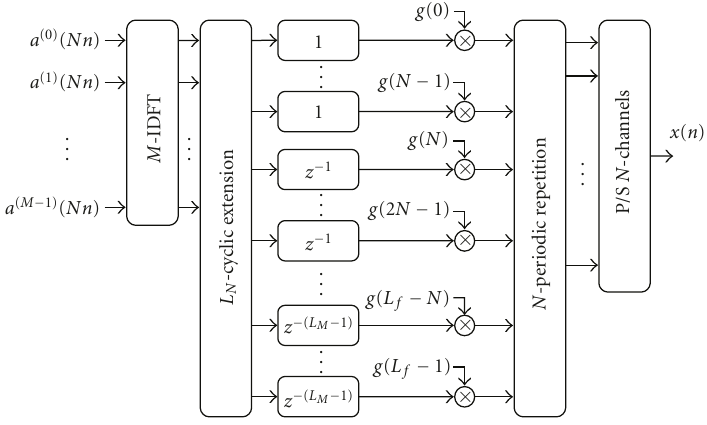
Figure 6: Synthesis bank (method C).